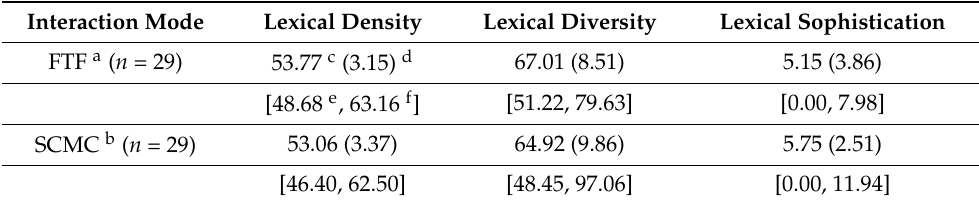
Table 1. Descriptive statistics for lexical density, lexical diversity, and lexical sophistication across FTF and SCMC interaction modes.